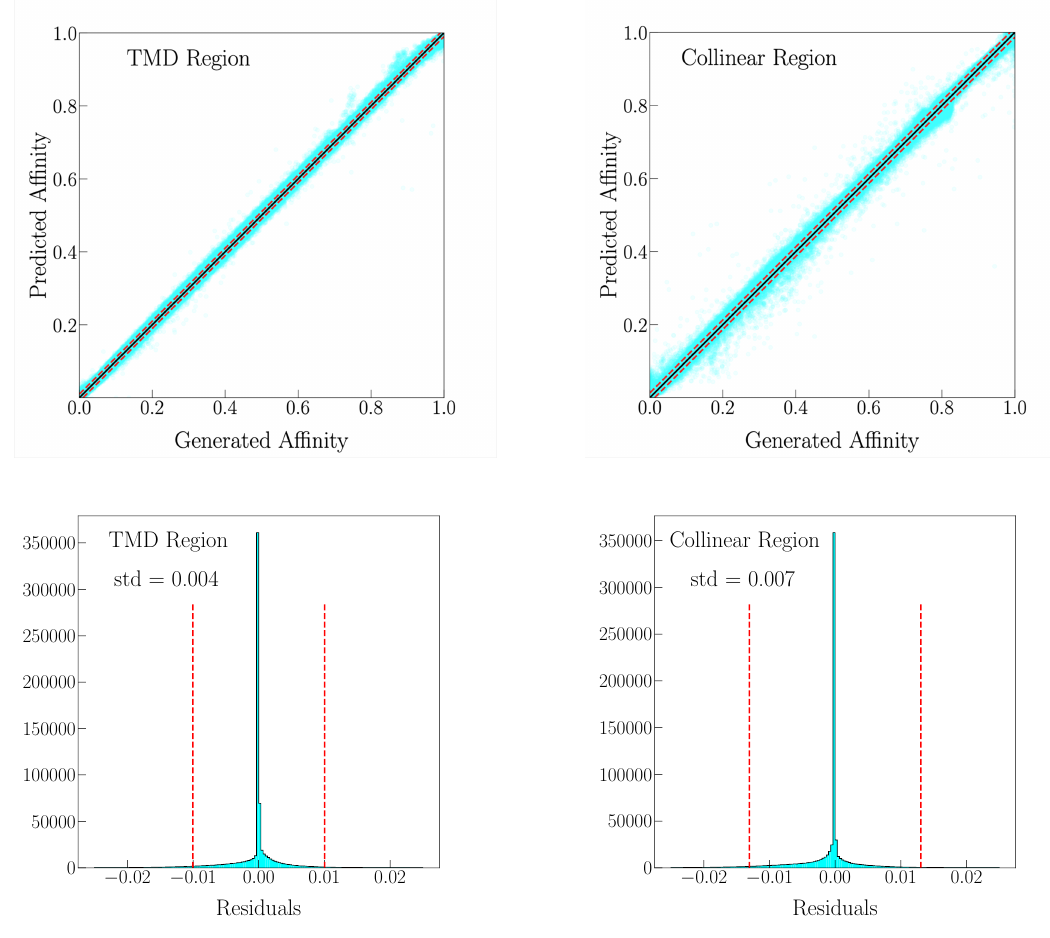
Figure 17 . Upper panels: scatter plots of predicted affinity versus the affinity generated with test data. The left (right) panel corresponds to the TMD (collinear) affinity. In each panel the black solid central line represents a perfect prediction, corresponding to zero residuals, while the points located between the two parallel red dashed lines contain 95% of all residuals. Lower panels: histograms of residuals for the TMD (left) and collinear (right) regions. The red dashed lines showing the intervals that contain 95% of all residuals, with the standard deviation “std” indicated. Note that the actual range of the residual values is wider than that shown in the histograms, but the outliers in the plots are omitted for better visual